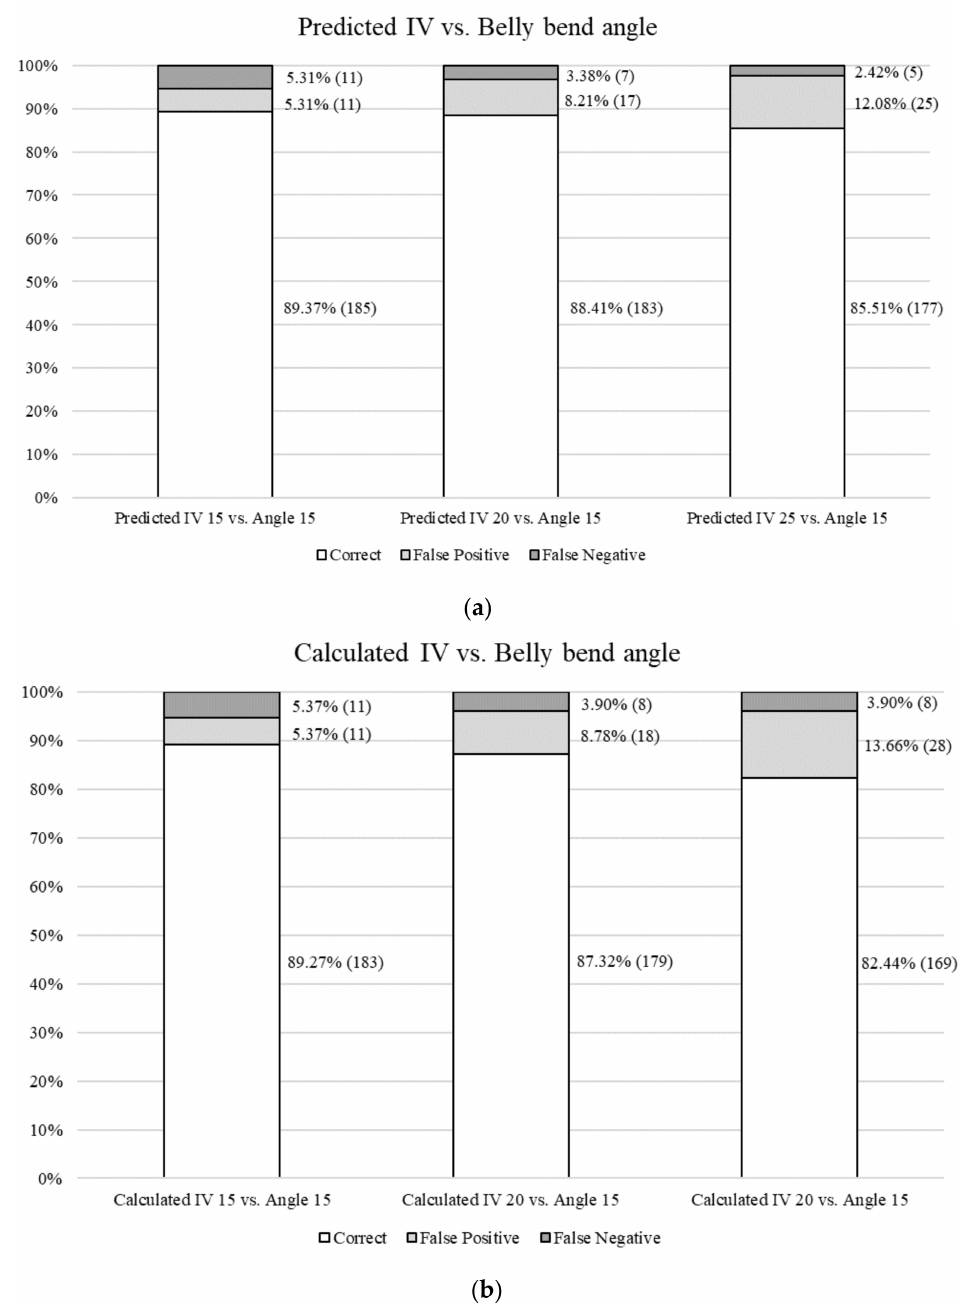
Figure 2. Comparison of levels of stringency for SOFT and FIRM classification thresholds (softest 15, 20 and 25%) for ( a ) predicted iodine value (IV) using an in-line near-infrared probe (NitFom™) inserted into the dorsal portion of the shoulder, above the shoulder blade and ( b ) calculated IV using wet chemistry methods, in comparison to the belly bend angle classi-fication threshold (softest